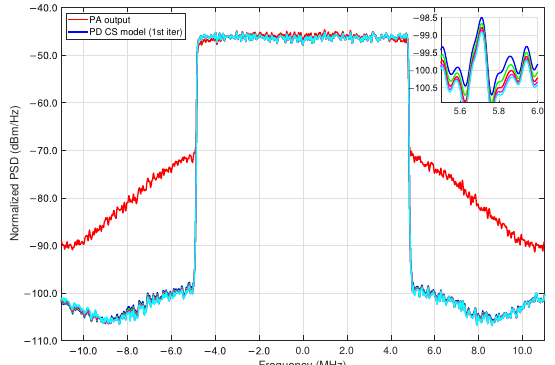
Figure 15. PSD for the LTE 10-MHz PA output signal and the CS prediction model with the actual predistorter z ( n ) model normalization ≤ = 0.9999 after 5 iterations reach an NMSE = − 48.7995 @ 2.45